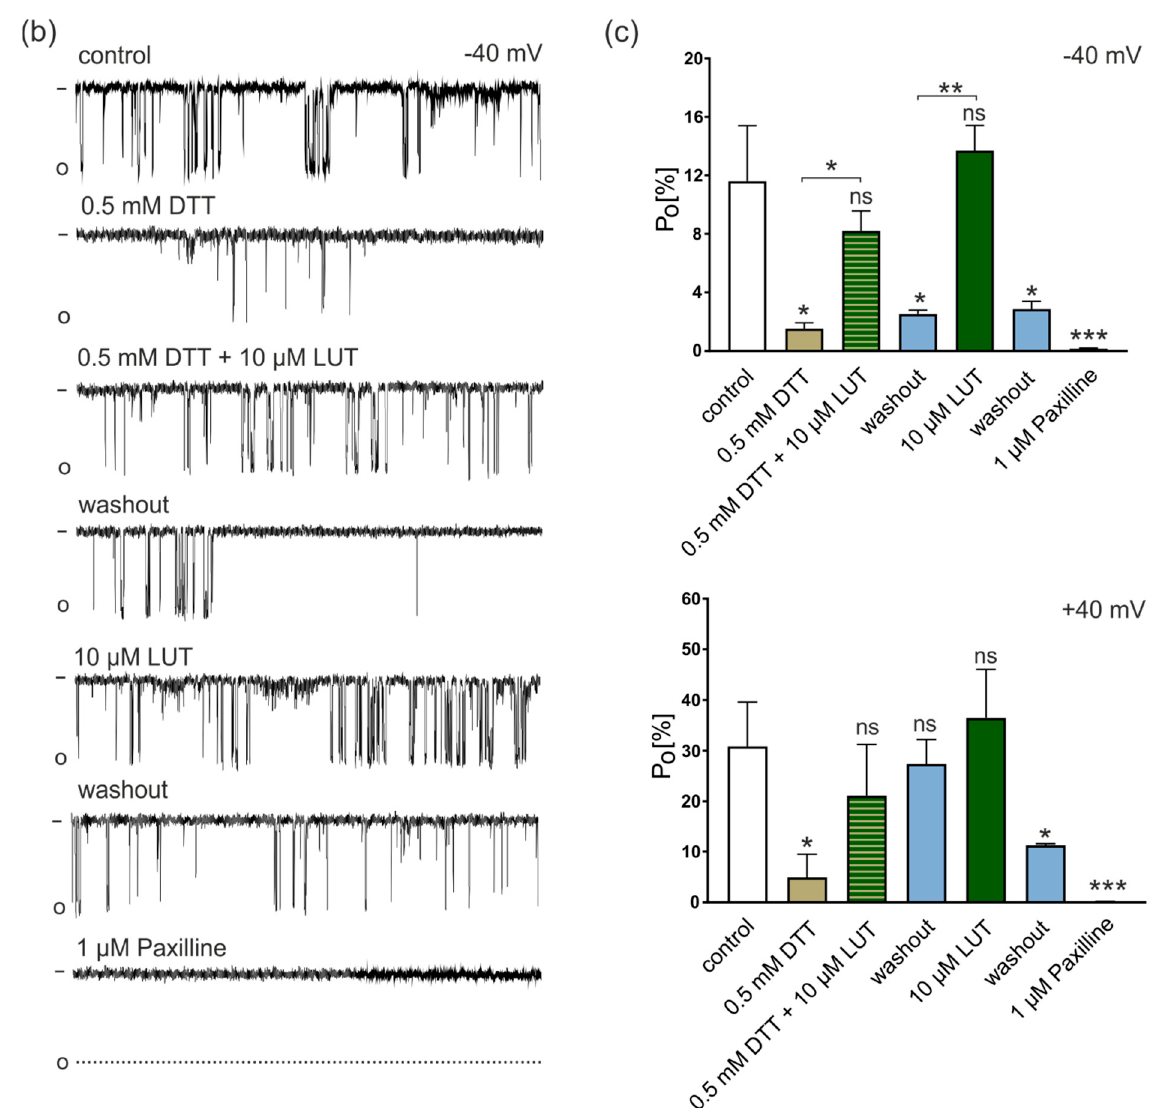
Figure 3 . Regulation of mitoBK Ca channel activity by LUT. ( a ) Effect of LUT on the activity of the mitoBK Ca channel under control conditions . The figure shows the activity of the mitoBK Ca channel present in the inner mitochondrial membrane of vascular endothelial cells and after the administration of 10 μ M LUT. The presented records were obtained − 40 mV in a symmetrical buffer of 150/150 mM KCl, in the presence of 100 μ M Ca 2+ , pH = 7.2. “-” means the closed state of the channel; “o” means the open state of the channel. ( b ) Regulation of mitoBK Ca channel by LUT in reduced conditions. Exemplificative recordings of channel activity under control conditions, then reduced conditions of 0.5 mM DTT, reduced conditions of 0.5 mM DTT in the presence of 10 µ M LUT, after washout to control conditions, after administration of 10 µ M LUT without DTT, after the second washout and under the influence of 1 µ M paxilline. The measurements were made at +40 mV and − 40 mV in a symmetrical buffer of 150/150 mM KCl, in the presence of 100 µ M Ca 2+ , pH = 7.2. “-” means the closed state of the channel; “o” means the open state of the channel. ( c ) Analysis of the probability of channel openings (P o ). P o evaluation for the individual stages of the experiments in part ( b ) with the determination of the levels of statistical significance (one-way ANOVA with Tukey’s test), n = 4 ( p < 0.05 (*); p < 0.01 (**); p < 0.001 (***); p > 0.05 (ns)). Due to the lack of influence of LUT on the activity of the mitoBK Ca channel under the control conditions, we decided to change the redox state of experimental